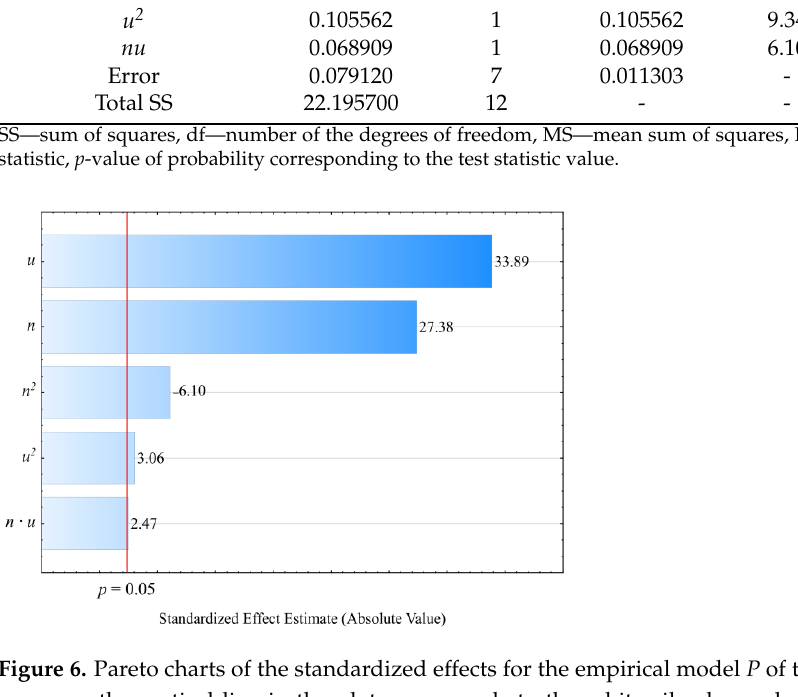
Figure 7. Response surface graph for the polymer blend pressure P versus the screw rotational speed n and bran mass fraction u. 3.1.4. Specific Energy Consumption The obtained results of measuring the power consumed by the extruder and the mass flow rate of the extruded blend were used to calculate the specific energy con- sumption supplied to the extruder E jc . The empirical model describing the specific energy consumption was determined in the form of a polynomial (Equation (5)): (cid:1831) (cid:3037)(cid:3030) = 2221.4 − 13,027(cid:1866) + 0,034(cid:1866) (cid:2870) (5) The statistical analysis involving the impact of the studied extrusion conditions on the specific energy consumption showed that extruder screw rotational speed n had a statistically significant impact (Figure 8). The statistical analysis results regarding the